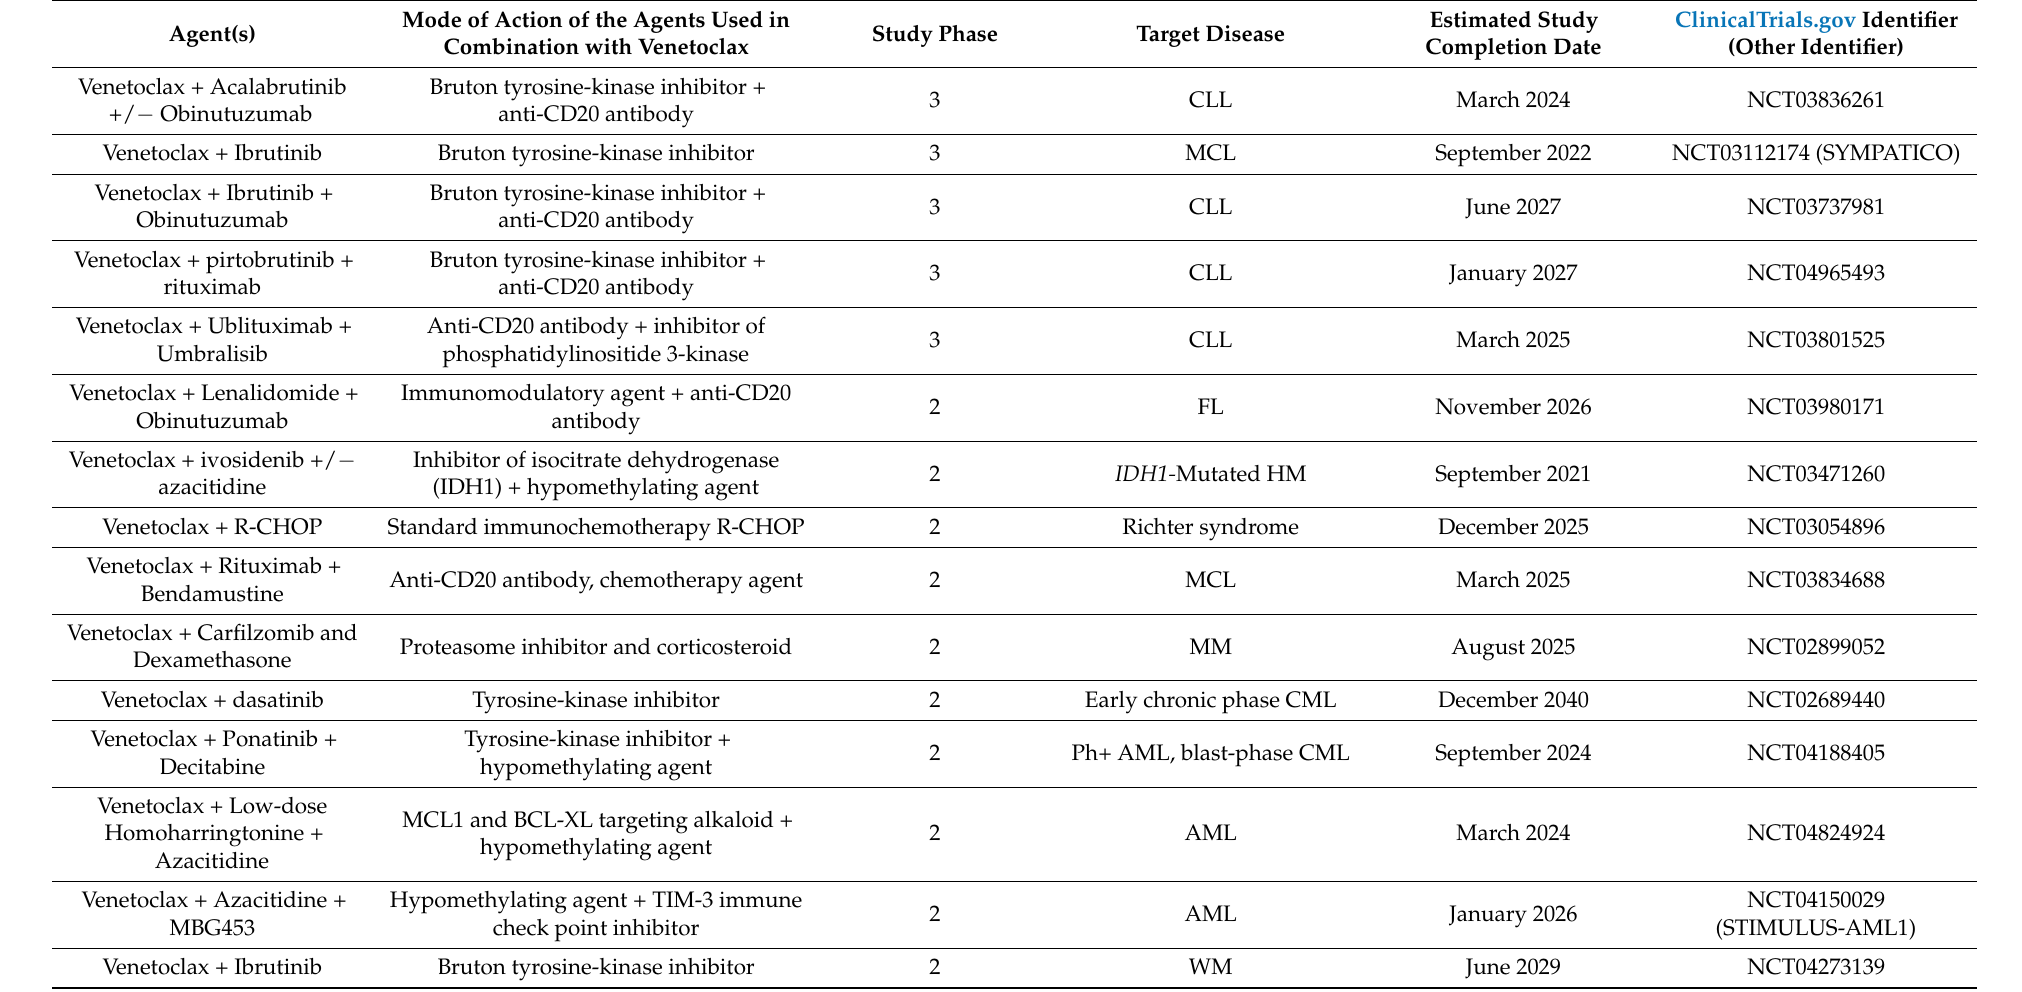
Table 4. Selected clinical trials that incorporate venetoclax in experimental therapy of hematologic